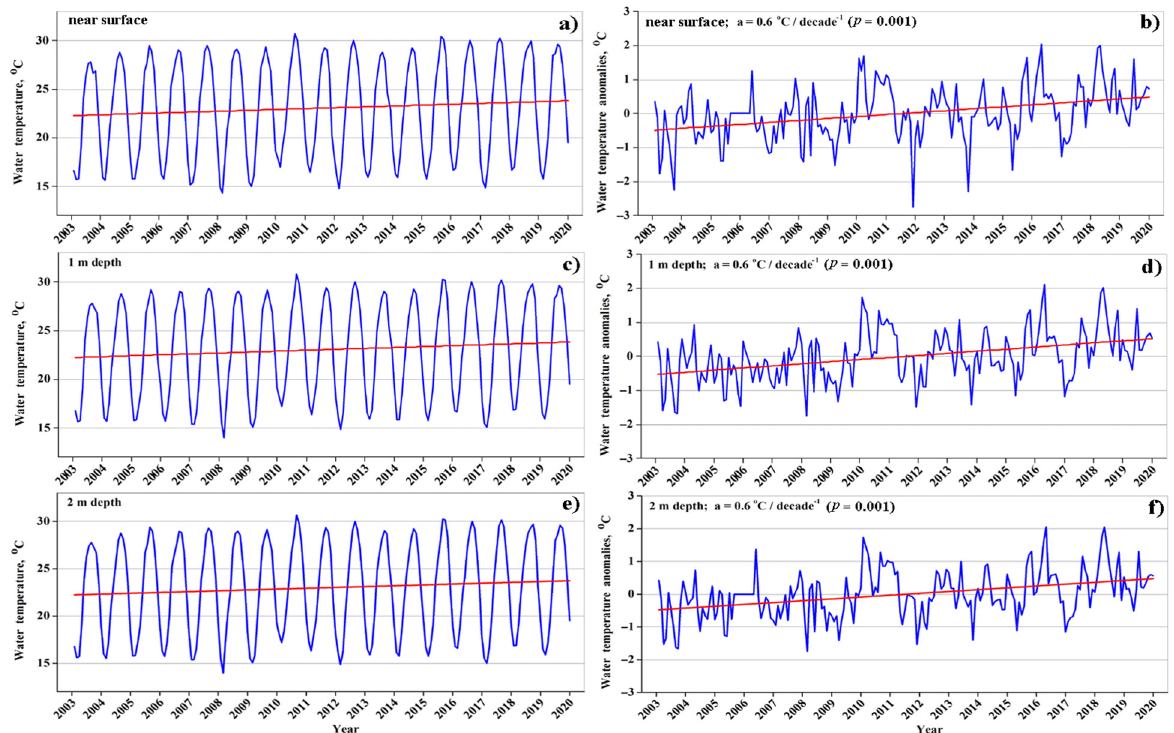
Figure 3. Month-to-month variations of ( a , b ) Kinneret near-surface water temperature; water temperature at ( c , d ) a depth of 1 m and at ( e , f ) a depth of 2 m; based on in situ measurements, during the 17-year period under study. The left column ( a , c , e )represents original monthly data while the right column ( b , d , f ) represents their associated deseasonalized monthly anomalies. The straight red lines designate linear fits.